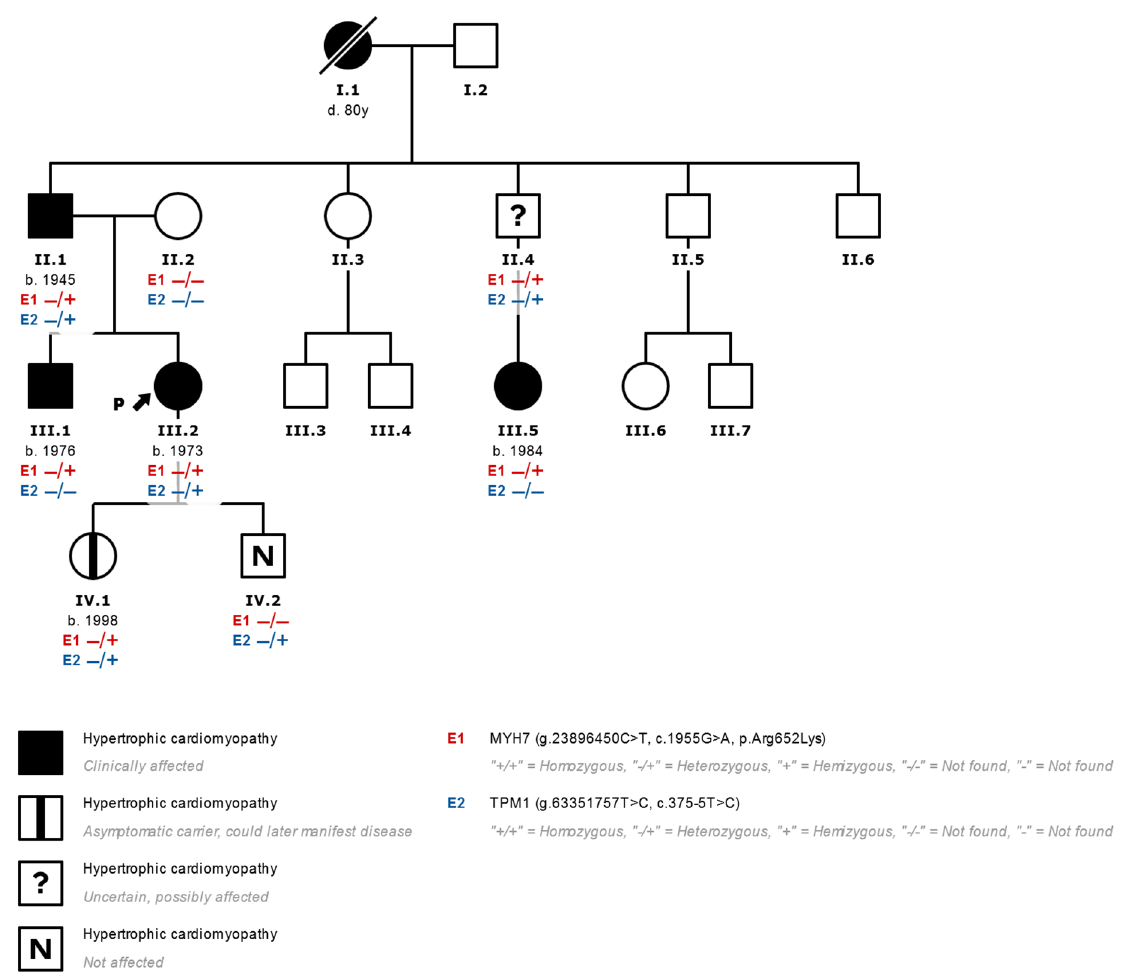
Figure 2. Family tree of a family studied with the finding of two variants that are potentially associated with heart disease (III.2 corresponds to index case N ◦ 5 in Table 1). In genetic studies of patients with HCM and the finding of more than one variant that is not clearly associated with HCM, the pathogenicity of all the variants found should be considered and their family segregation evaluated. In this case, the presence of variants in the MYH7 (E1) and TPM1 (E2) genes is seen in the index case (arrow) with a diagnosis of HCM (effects indicated in black). We observed that only the variant p.Arg652Lys in MYH7 segregates together with the development of HCM in relatives, which is evident in the brother and in a cousin of the index case who presented HCM and only presented the variant in MYH7 without alterations in TPM1 . Patients with the MYH7 variant and no HCM phenotype are marked with a central black mark. −/−: Variant not found. −/+: Heterozygous variant found.